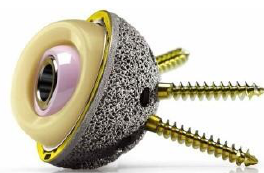
Figure 1. G7 Dual Mobility Acetabular system ® is a cup made of a titanium-alloy core, with mi- croporous outer surface and multiple holes to improve fixation with additional screws if needed. A polar pilot hole allows for proper insertion of the chrome-cobalt definitive liner; it is coupled with a large head in highly-crosslinked polyethylene. The femoral head is compressed into it in- traoperatively.